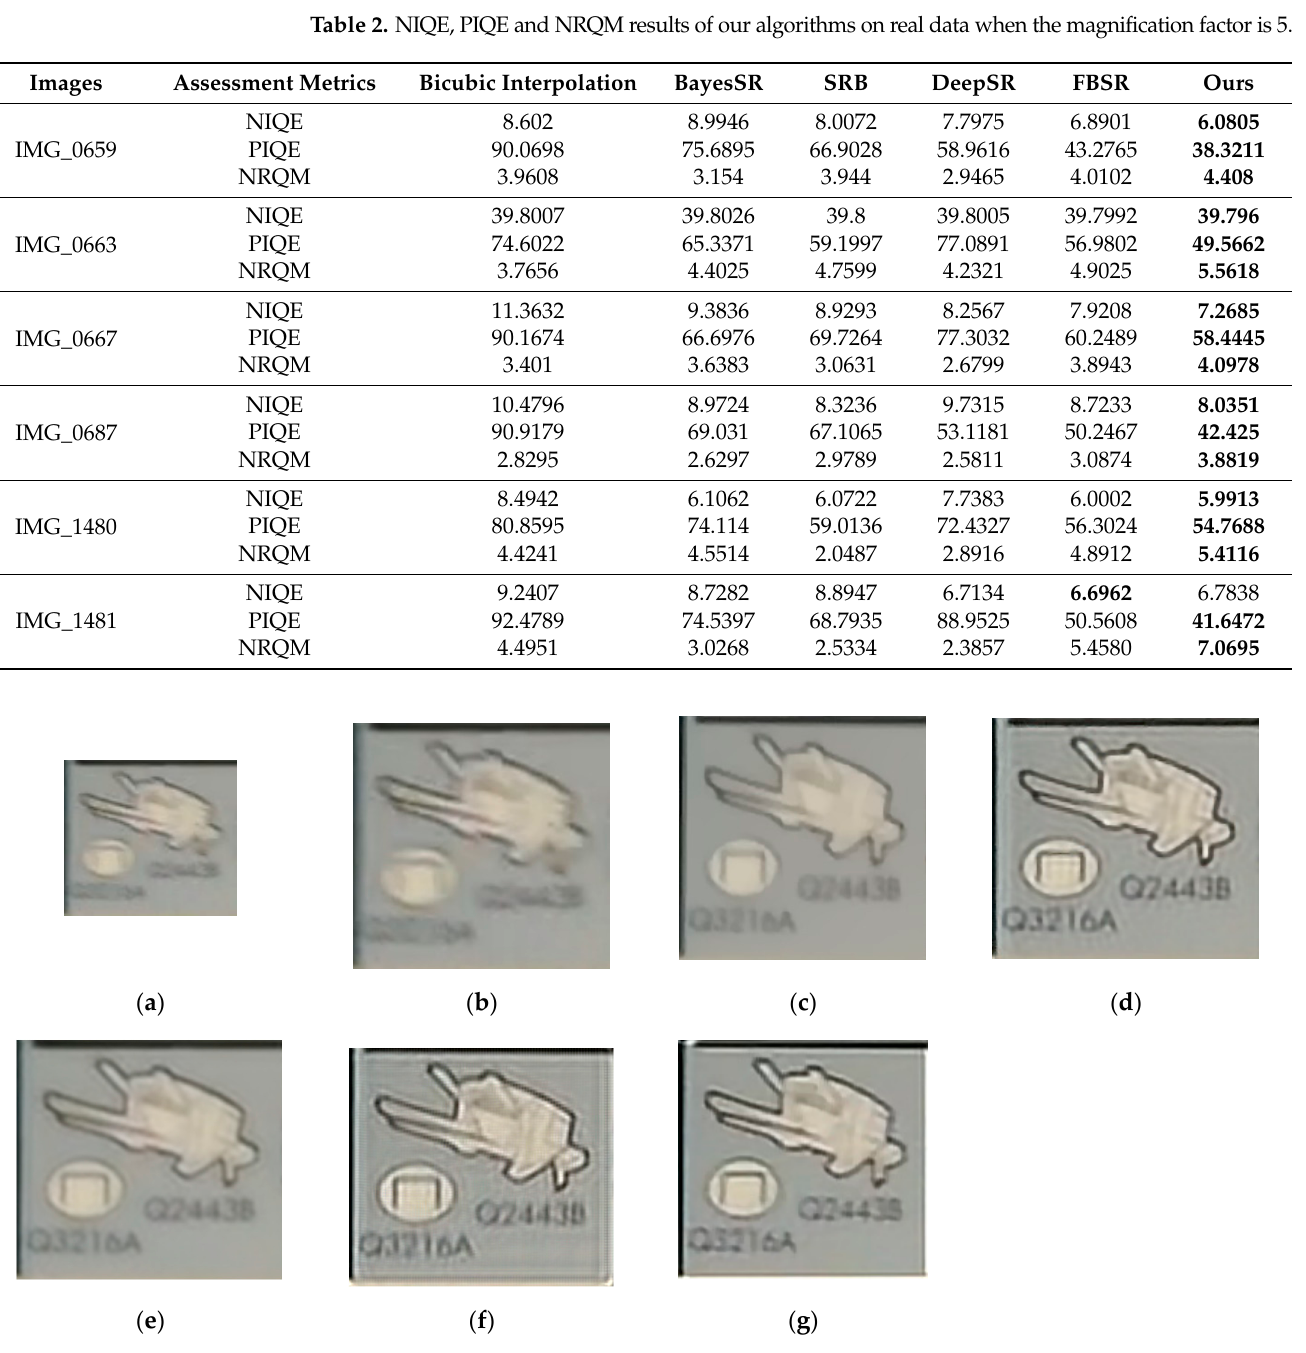
Table 2. NIQE, PIQE and NRQM results of our algorithms on real data when the magnification factor is 5.